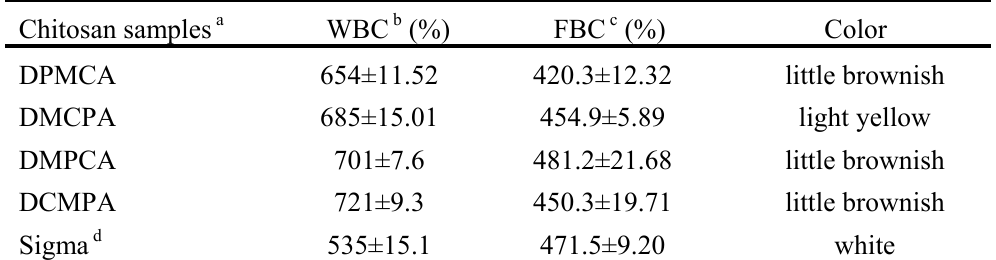
Table 3. WBC, FBC and color of A. urmiana and commercial chitosan